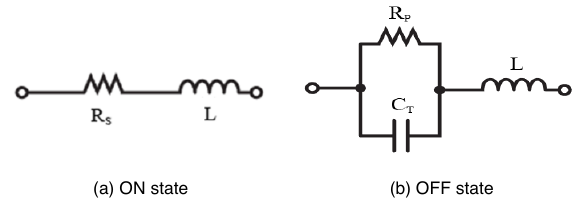
The ON state is achieved by series resistor R S with inductor L while the OFF state is made by parallel resistor R P with the capacitor C T then connected in series with the inductor L. The values of L, R S , R P , and C T in the two on-off states are described in Table II. It is obvious that the lower value of R S in the RL circuit allows current flow from the feeding line to the radiating patches and the higher value of R P , C T in RLC circuit prevents the current from flowing between the radiating patch and feeding